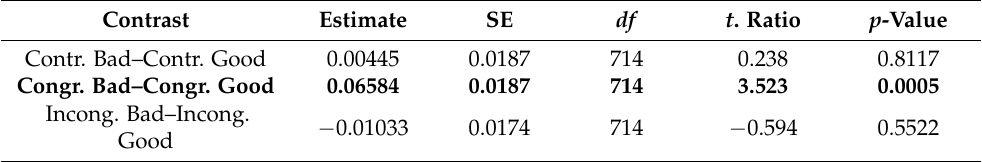
Table 4. Results of paired-contrast analysis for each Deck × Condition combination. Approximated p -values have been computed with Tukey’s correction adjustment.